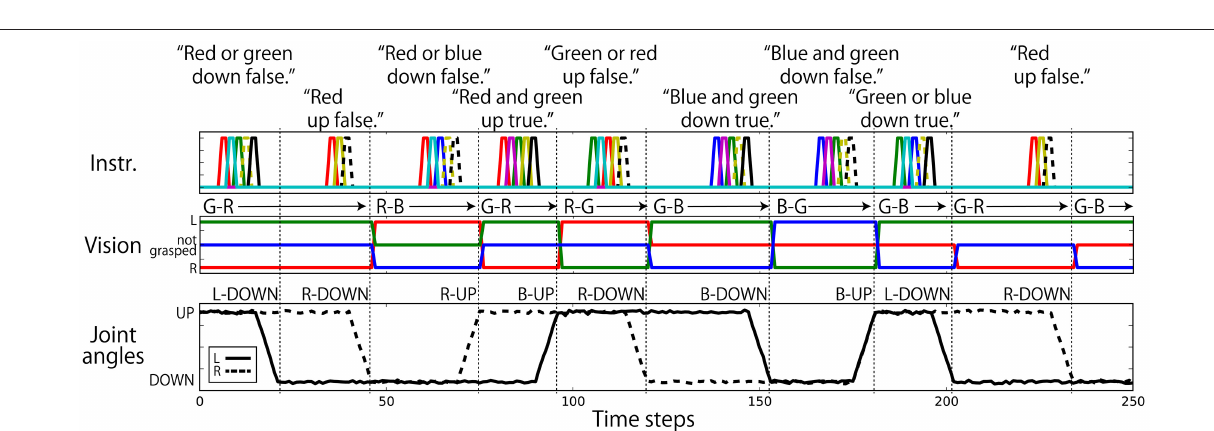
FIGURE 3 | An example sequence that represents the flag task. Each vertical broken line indicates the end of an episode. (Top) An instruction is given as a succession of words, which are each represented as a 1-hot vector. In the waiting and action-generation phases, zero-filled vectors are given. (Middle) Visual information is continuously given as a sequence of three-element (R, G, B) vectors. The flag colors can be changed randomly just after action generation. Because this task was numerically simulated on a computer, changes in flags were represented as instantaneous changes in values. Note that flags are sometimes not changed as in the case from the first episode to the second episode in this figure. (Bottom) Each action immediately follows an